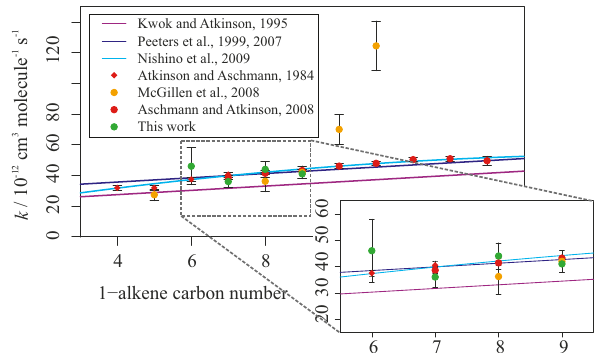
Figure 6. Plot showing experimentally derived (data points) and predicted SAR-derived (lines) k values for 1-alkenes. Data from this study are shown in green; they are in good agreement with both previous experimentally derived results and with theoretical SARs.